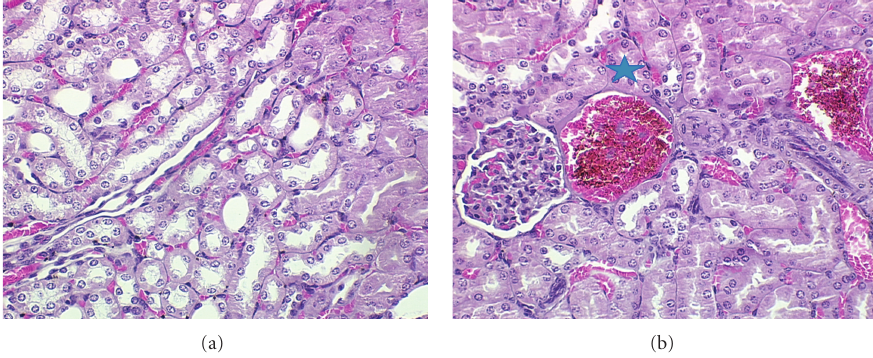
Figure 6: Histological assays. Groups of BALB/c female mice were injected i.p. with 1 LD 50 of Cdt for di ff erent times as above described. The levels of cytokines excreted in urine were determined as described in Section 2. Each point represents the mean value of samples from four experiments in di ff erent groups of five mice. Statistical di ff erences between the treatments were ( P > 0 .